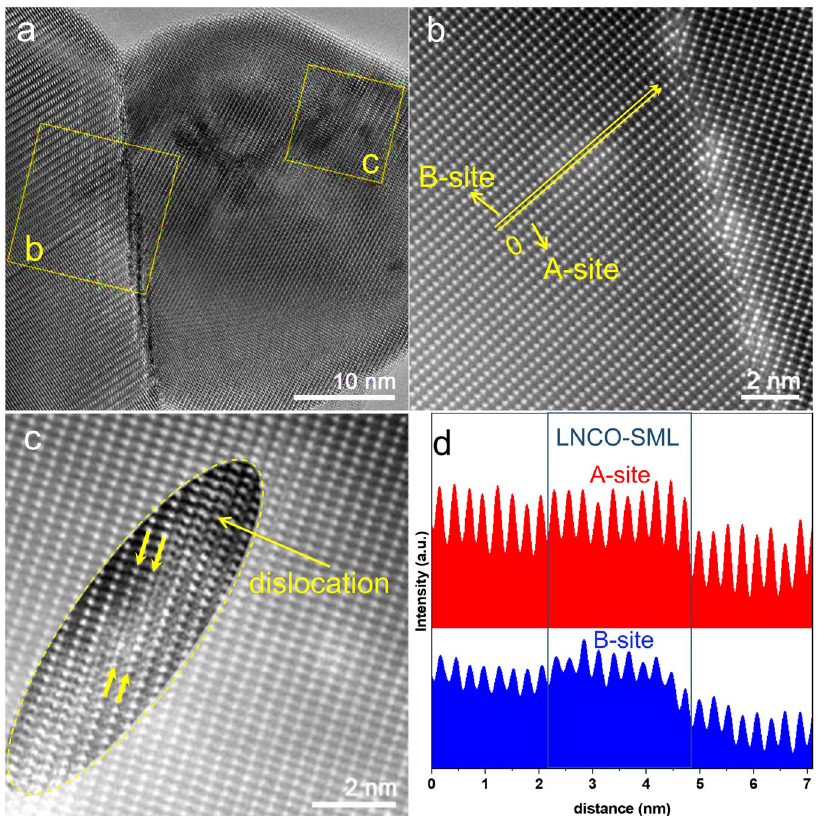
Fig. 6 HR-TEM and HAADF images of LNCO-R sample. a HR-TEM, b , c HAADF images of LNCO-R sample corresponding to the yellow squares in a . d The line pro fi le across A- and B-site elements as indicated in b . The contrast in the ellipse in c was enhanced to highlight the dislocation in LNCO-SML. The surface direction is [020]. LNCO-R represents H 2 -reduced LaNi 0.05 Co 0.05 Cr 0.9 O 3 sample. LNCO-SML represents La(NiCo)O Δ submonolayer.